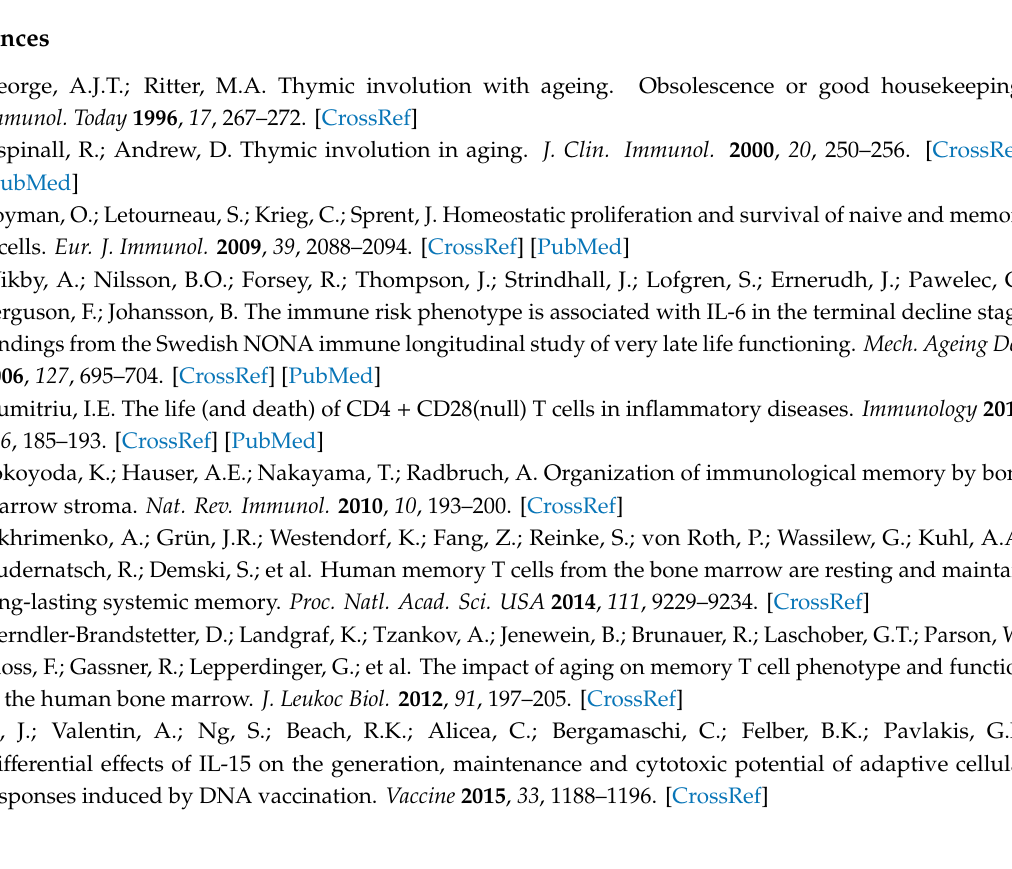
Figure S1: Titration of optimal Vc concentration to use in the study, Figure S2: T cell subsets in the PB, Figure S3: E ff ector / memory T cell subsets in the PB of young and old mice, Figure S4: E ff ector / memory T cell subsets in the BM and spleen of young and old mice, Figure S5: Frequency of IL-6 + cells; Figure S6: Expression of pro-inflammatory molecules within CD4 + T cells in the BM and spleen, Figure S7: Representative FACS plots, Figure S8: Frequency of CD80 and CD40 in DC